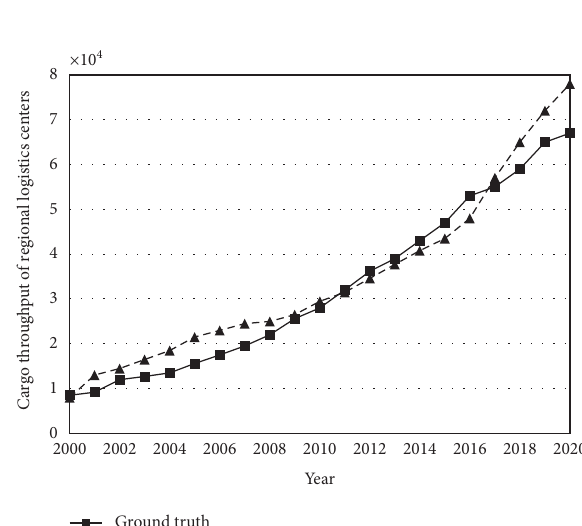
Figure 3: Training results of GM (1, 1) model.